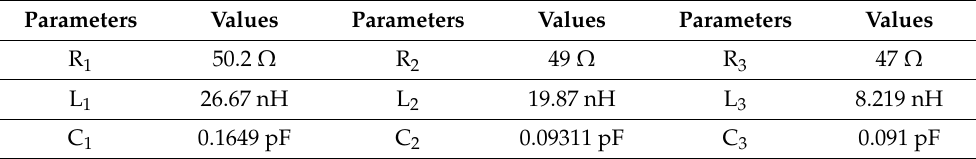
Table 2. The parameters of RLC equivalent circuit of the proposed antenna.